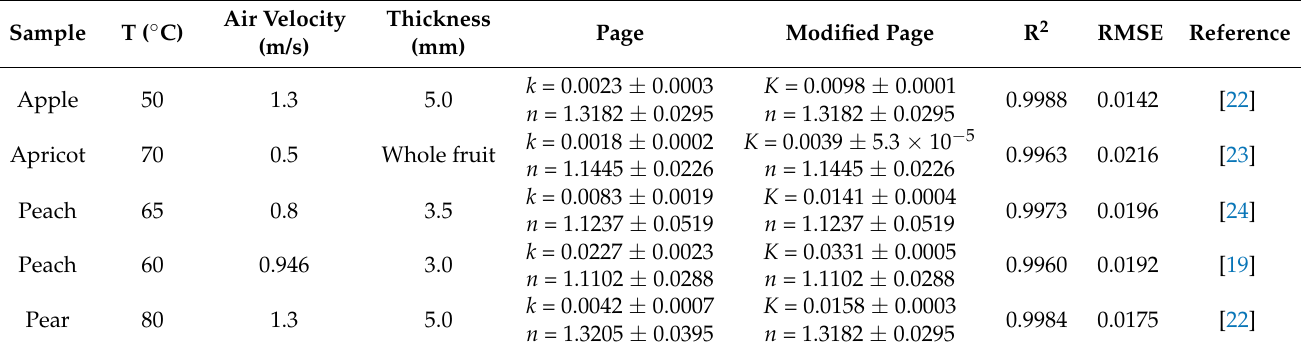
Table 1. Result of the fit of the Page [Equation (1)] and modified Page [Equation (2)] models to the published